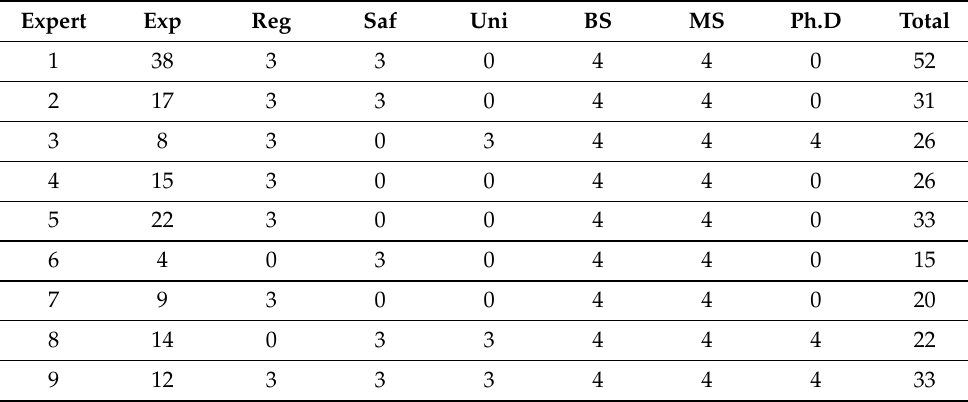
Table 4. Summary of experts scoring using Table 3. Expert